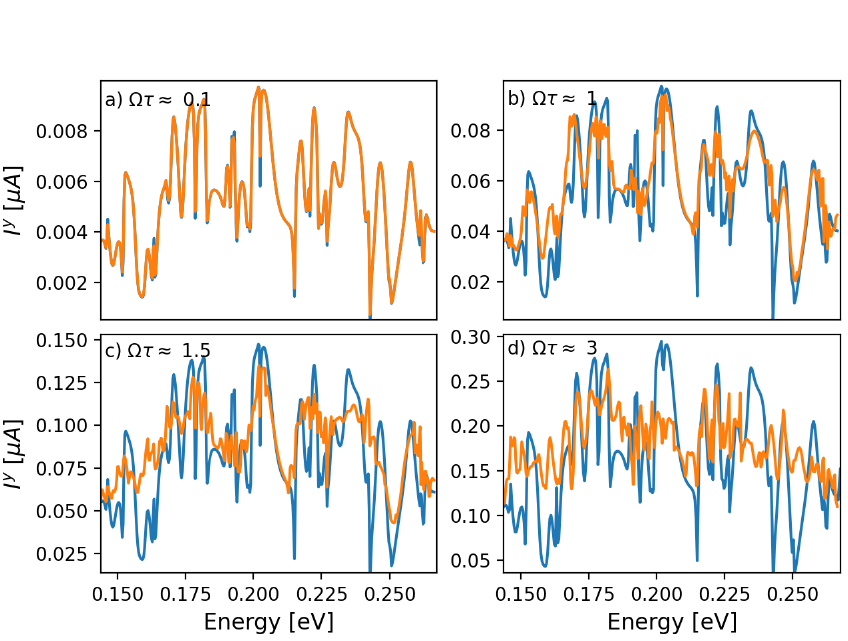
Figure 9: Spin currents for the chaotic ballistic system, Fig. 2, calculated by using the full Floquet scattering matrix (orange) and by the adiabatic approximation, Eq. (37) L = 1 and Ω τ ≈ 0.1 (a), 1 (b), 1.5 (c) and 3 (blue) for k so